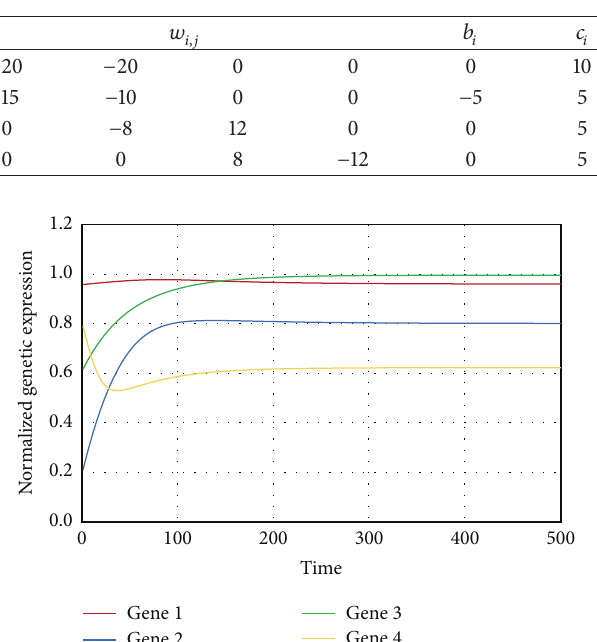
Figure 3: Network dynamics used for training the proposed model. The four lines represent the expression profile of the four genes.